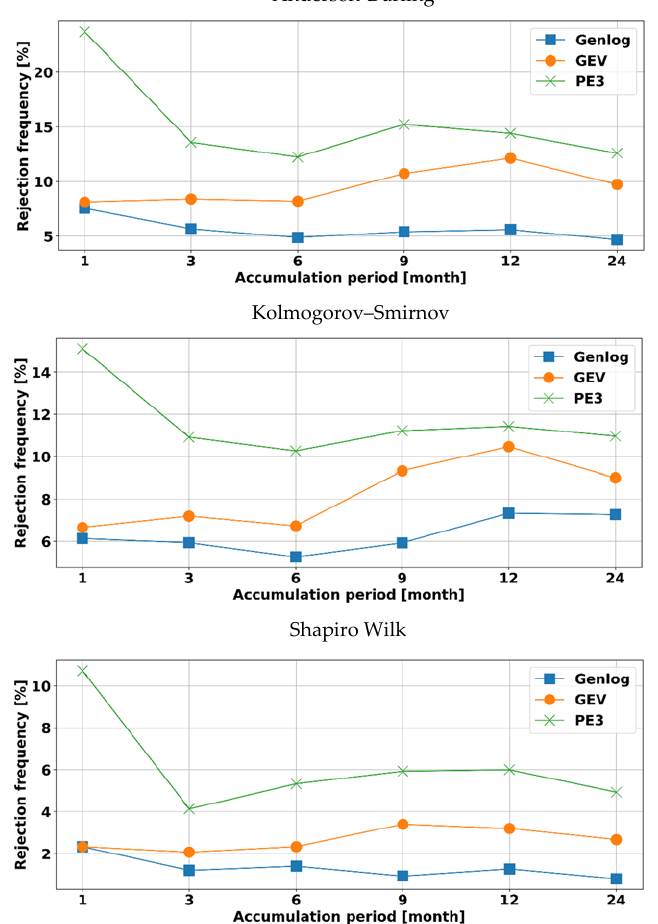
Figure 2. Rejection frequency (relative to 125 stations and 12 months per station) for the Anderson– Darling ( top ), Kolmogorov–Smirnov ( middle ), and Shapiro–Wilk ( bottom ) goodness-of-fit test at 5% significance level. The result is for the three SPEI candidate distribution functions for different accumulation